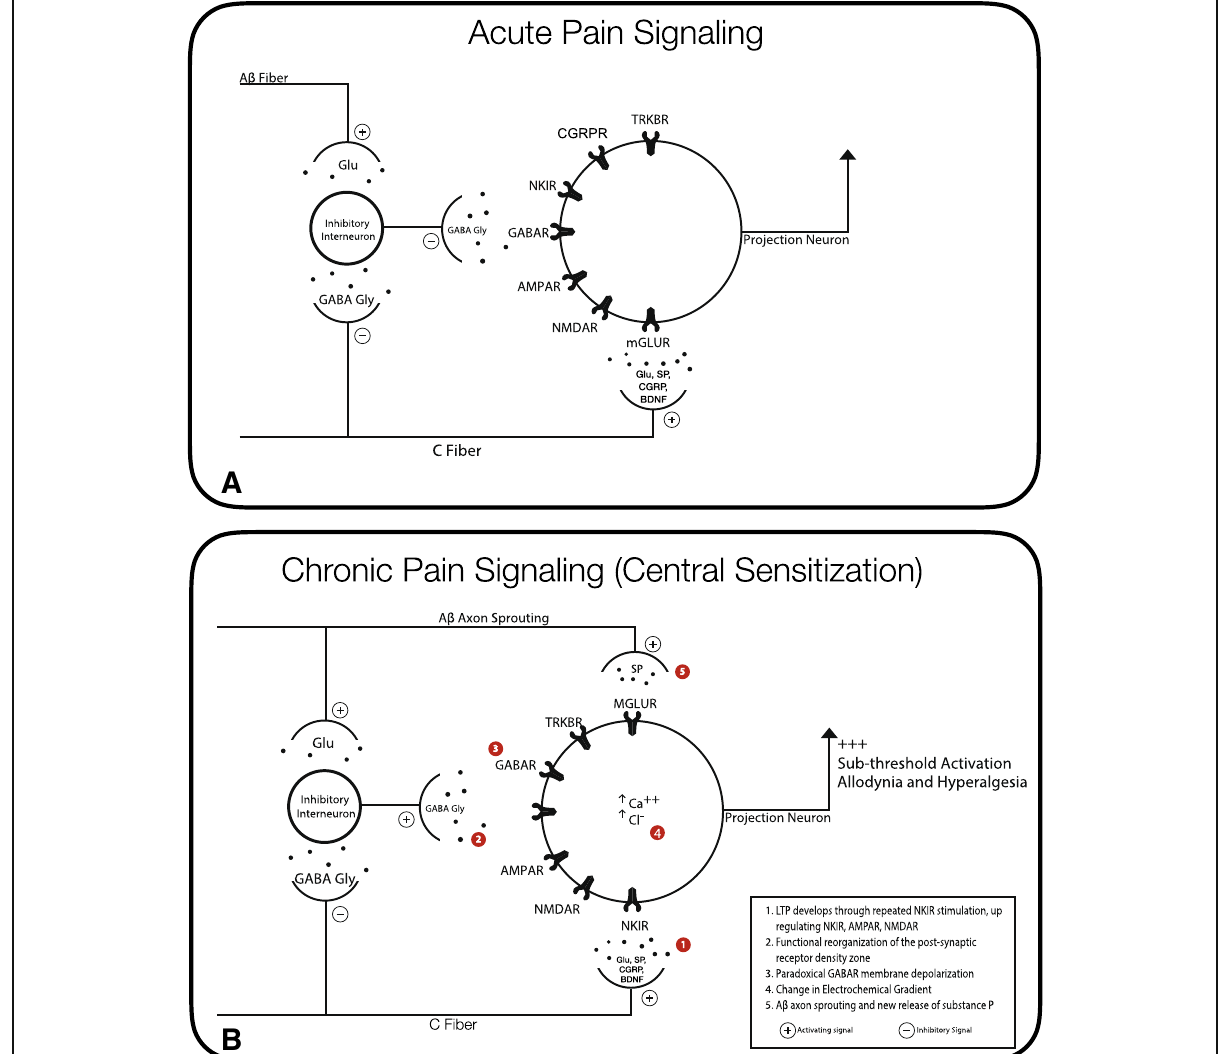
Fig. 3 Mechanisms of Hyperalgesia and Allodynia. Panel a ) Non-pathologic nociception whereby C-fiber and A β inputs relay through an interneuron to modulate ascending signals via the projection neuron. Panel b ) Nerve injury or repeated peripheral c-fiber stimuli leads to central sensitization through multiple mechanisms including changes in receptor kinetics, resting membrane potential and phenotypic transformation of A β afferent fibers. Through long term potentiation and altered receptor expression at the post receptor density zone, subthreshold stimulation evokes action potentials leading to classic hyperalgesia. A β axon sprouting after injury and secretion of substance P may offer further explanation for the development of tactile allodynia. Acronyms: Glu (Glutamate), Gly (Glycine), GABA (gamma amino butyric acid), SP (Substance P), BDNF (Brain Derived Neurotrophic Factor), CGRP (Calcitonin Gene Related Peptide), MGLUR (metabotropic glutamate receptor), TRKB (Tropomyosin receptor kinase), GABAR (GABA Receptor), AMPAR (AMPA Receptor), CGRPR (CGRP Receptor), NMDAR (NMDA Receptor), NK1R (Neurokinin-1 Receptor), LTP (Long Term